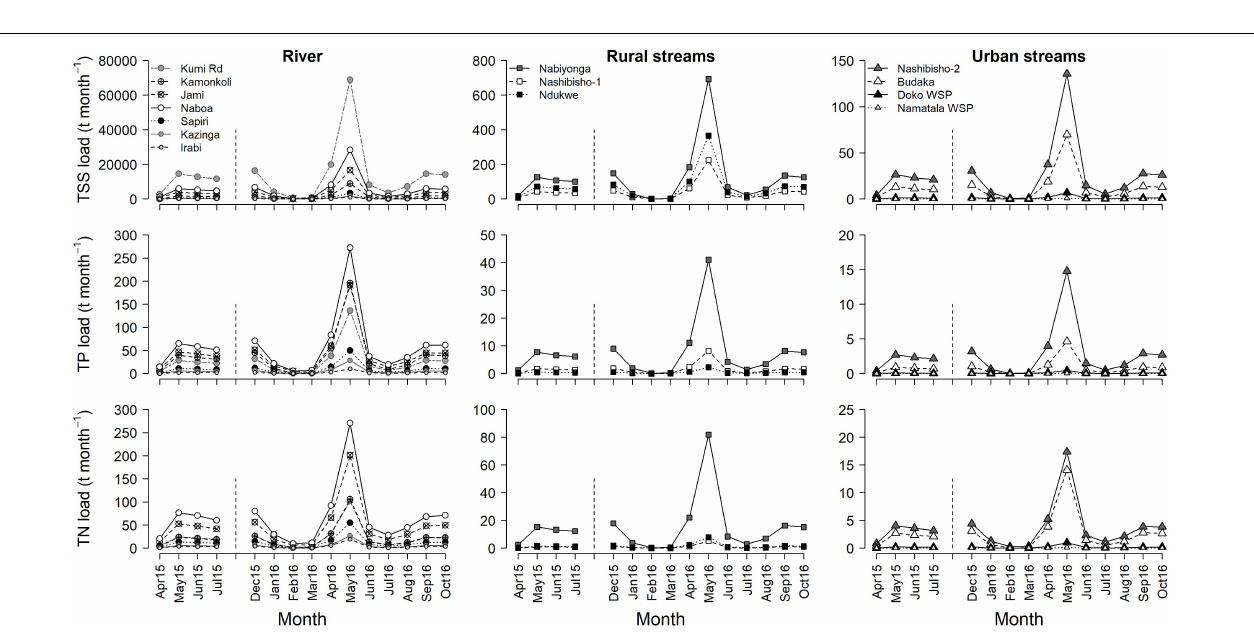
FIGURE 8 | Seasonal variation of water quality parameters in HGMUs 1–5 of Namatala Wetland, for the period April 2015–October 2016. (A) pH; (B) dissolved oxygen (DO); (C) electrical conductivity (EC); (D) total suspended solids (TSS); (E) ammonium nitrogen (NH4-N); (F) total nitrogen (TN); (G) soluble reactive phosphorus (PO 4 -P); (H) total phosphorus (TP).